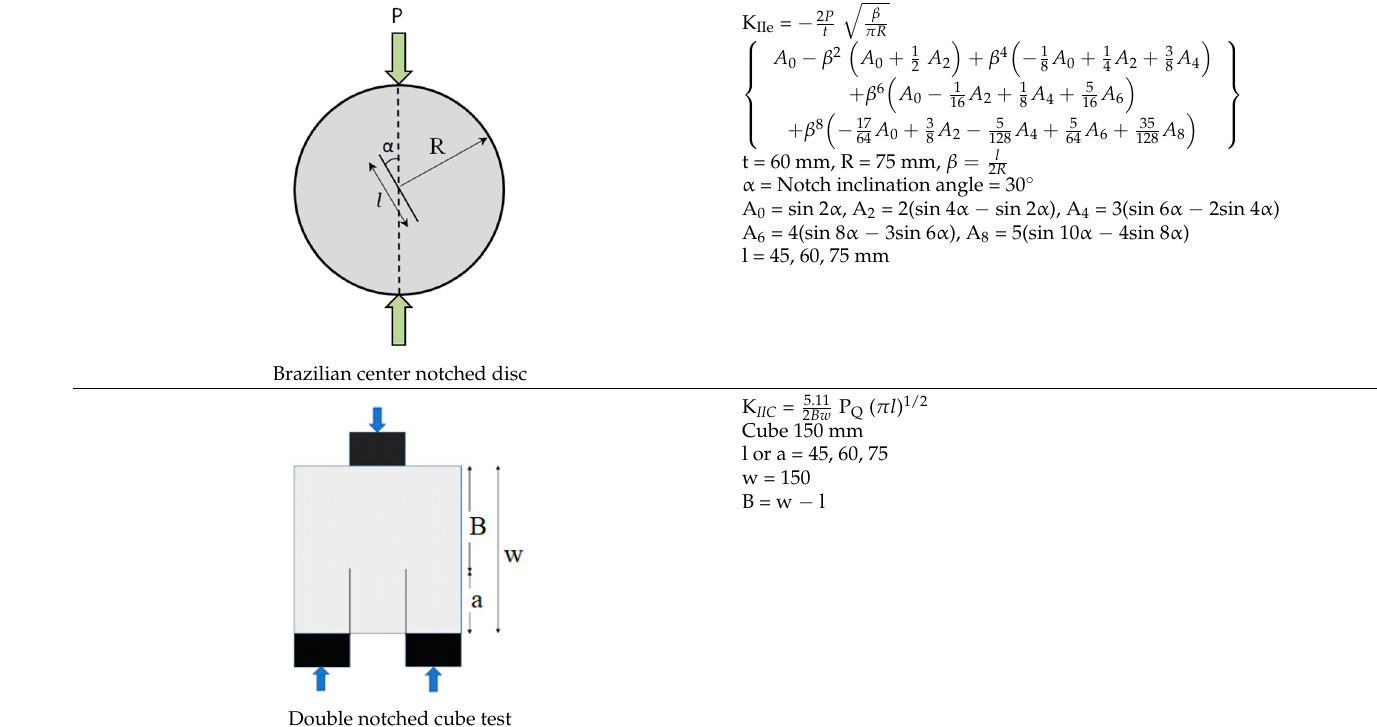
Table 3. Mode II fracture toughness test